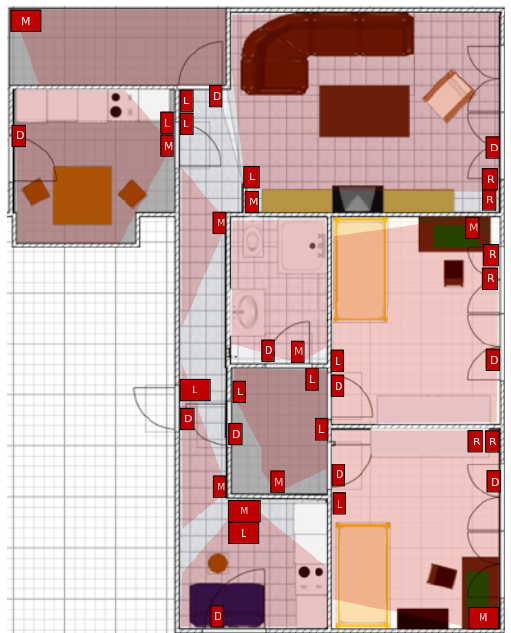
Figure 2. Blueprint of the flat equipped with contact ( D ) and motion ( M ) sensors as well as light switches ( L ) and roller shutter ( R )